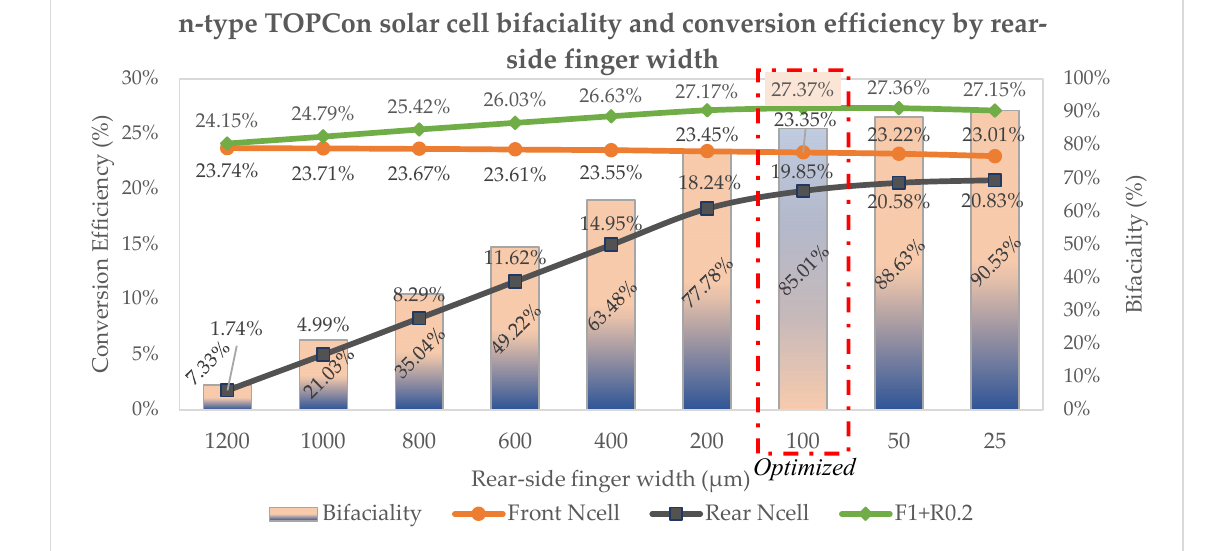
Figure 13. According to Table 2, the tunnel oxide layer’s optical thickness is 1.5 nm. We used this thickness for the bifaciality simulation in order to maximize the TOPCon solar cell’s overall performance.